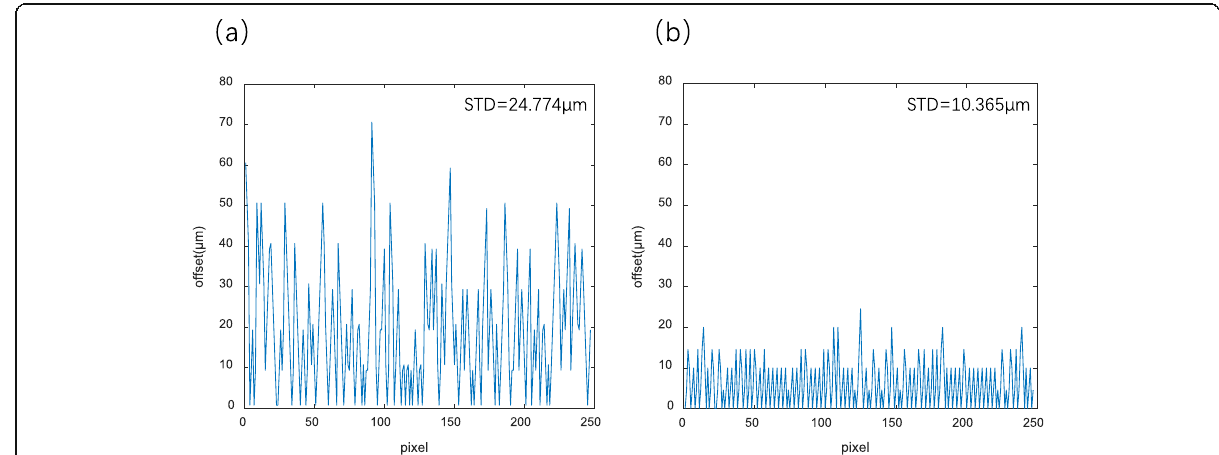
Fig. 9 Position offset of the x-coordinate position of each pixel. The offset is calculated using the absolute value. a Before correction and ( b ) after